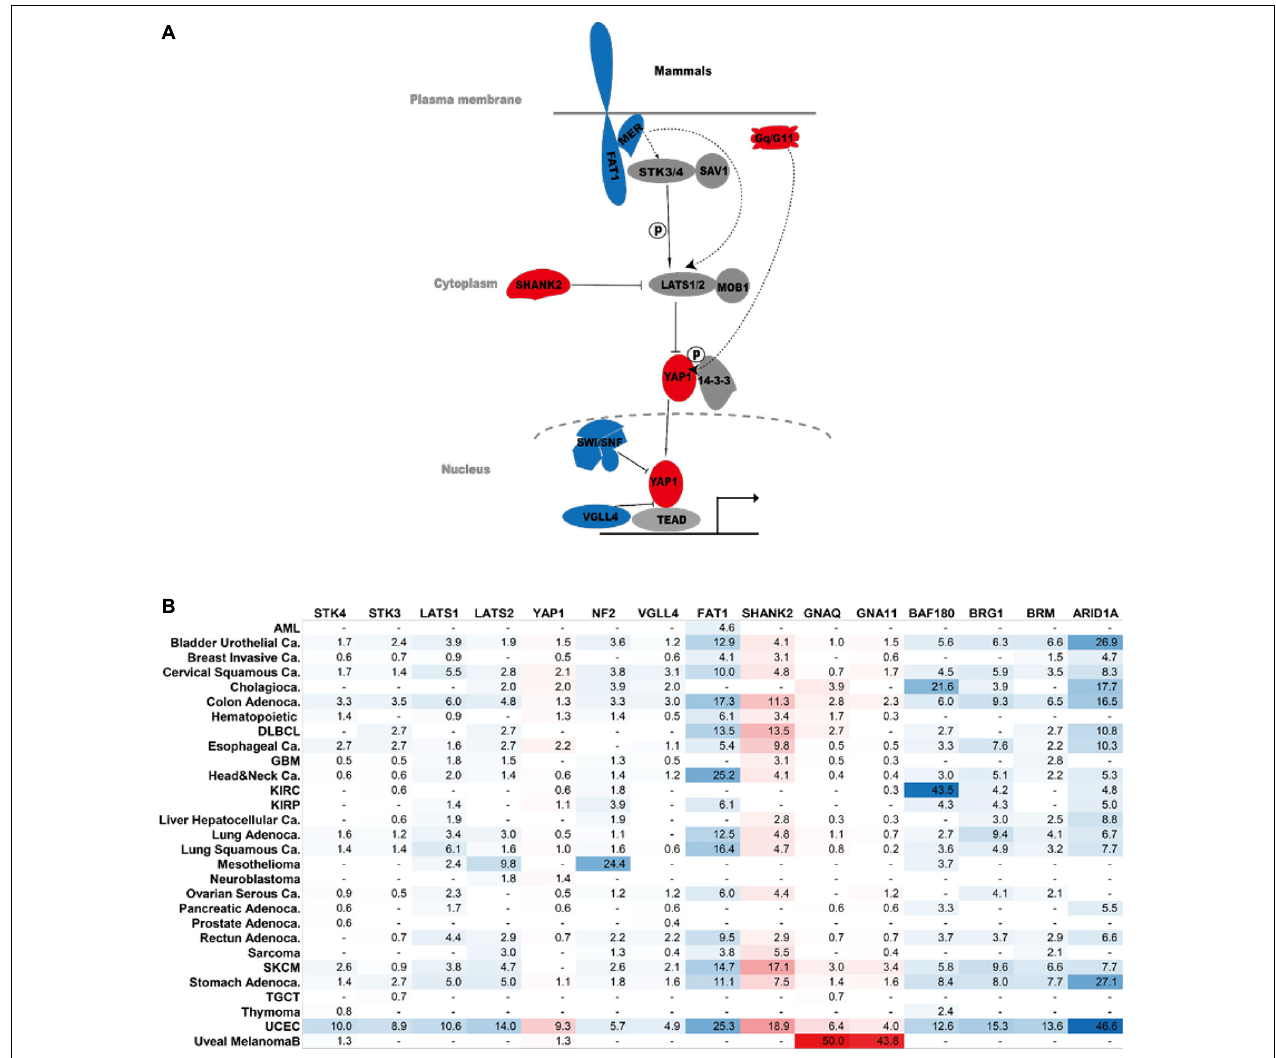
FIGURE 3 | Hippo components in human cancer. (A) Major cancer players of the Hippo signaling pathway. Genes in red are oncogenes. Genes in blue are tumor suppressors. (B) Percentage of genetic abnormalities of the indicated Hippo pathway components in human cancer. The analysis was performed on The Cancer Genome Atlas dataset. AML, acute myeloid leukemia; DLBCL, diffuse large B cell lymphoma; GBM, glioblastoma multiforme; KIRC, kidney renal clear cell carcinoma; KIRP, kidney renal papillary cell carcinoma; SKCM, skin cutaneous melanoma; TGCT, testicular germ cell tumors; UCEC, uterine corpus endometrial